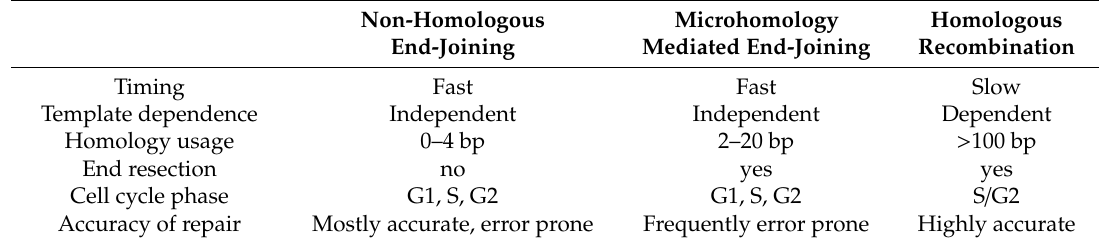
Table 2. Characteristics of the major double-strand break repair mechanisms